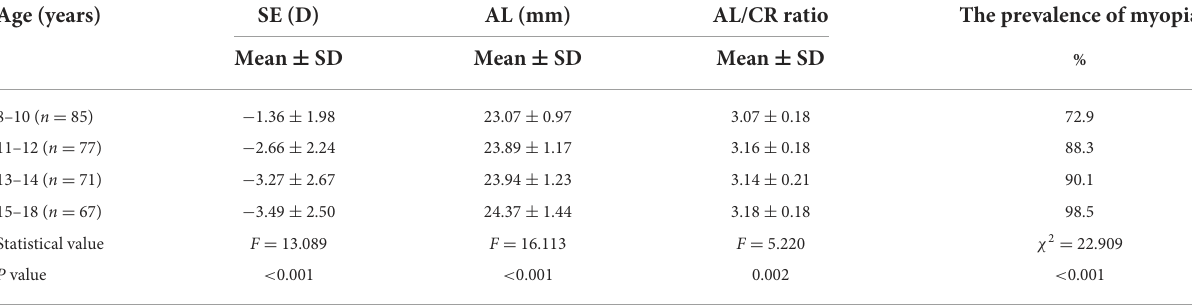
TABLE 2 The comparison of SE, AL, and AL/CR ratio of participants among different age groups.